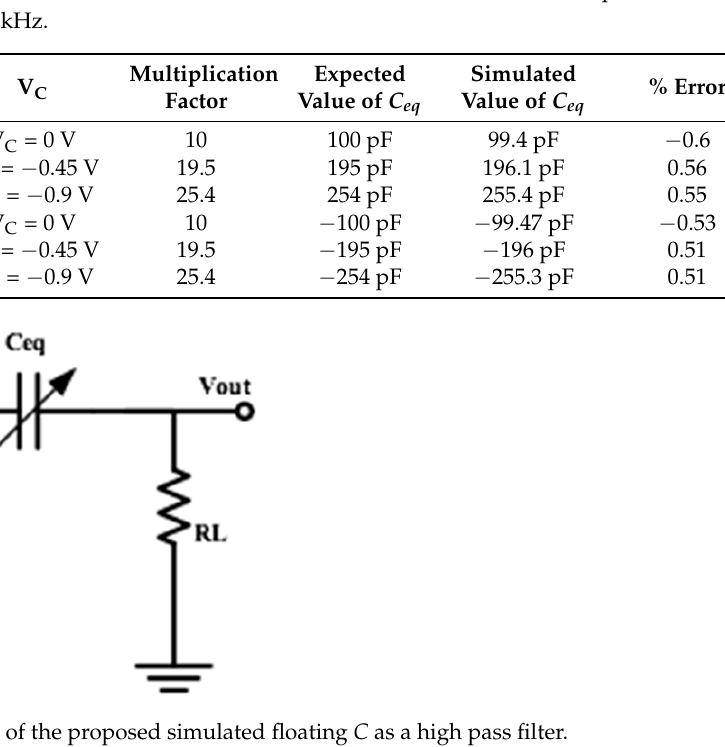
Figure 10. Frequency response of the high pass filter.